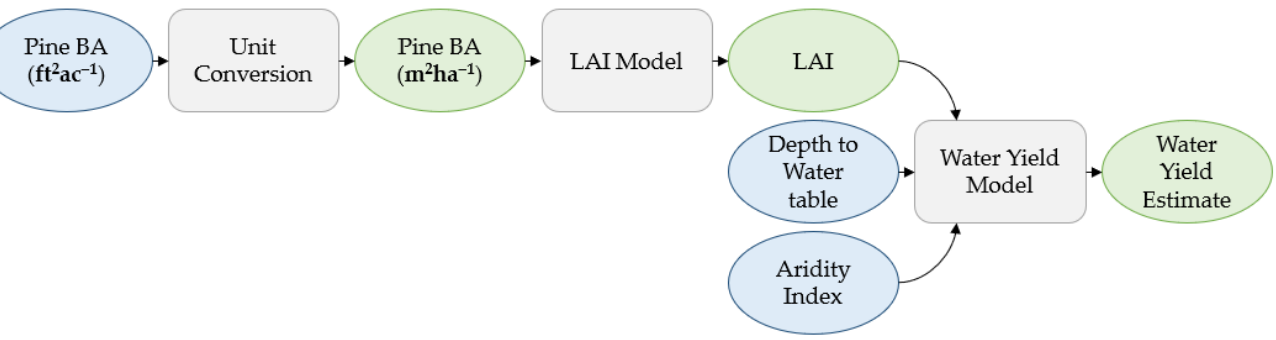
Figure 4. Aridity indexes (PET/precipitation) developed from yearly MODIS PET and PRISM precipitation data from the years 2013 to 2020 (excluding 2016). The mean pixel value across the time period is shown in ( a ) and the maximum ARID value, driest value, for each pixel is shown in ( b ). After calculating LAI, a baseline water yield estimate was produced by applying the general linear model from [5] shown in Equation (1) spatially across the study area. The output of this workflow (Figure 5) is an estimate of how much water (in centimeters per year) is predicted to return to the hydrologic system, across the study area at 10 m spatial resolution. We refer to this baseline output as the ‘current’ water yield, which reflects existing water yield conditions before any management activities are conducted.